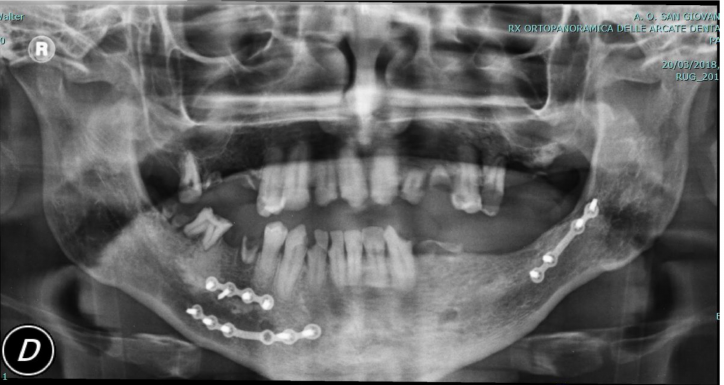
Figure 6. Pre-operative view showing fixation plates following jaw fracture care after the patient’s car accident.